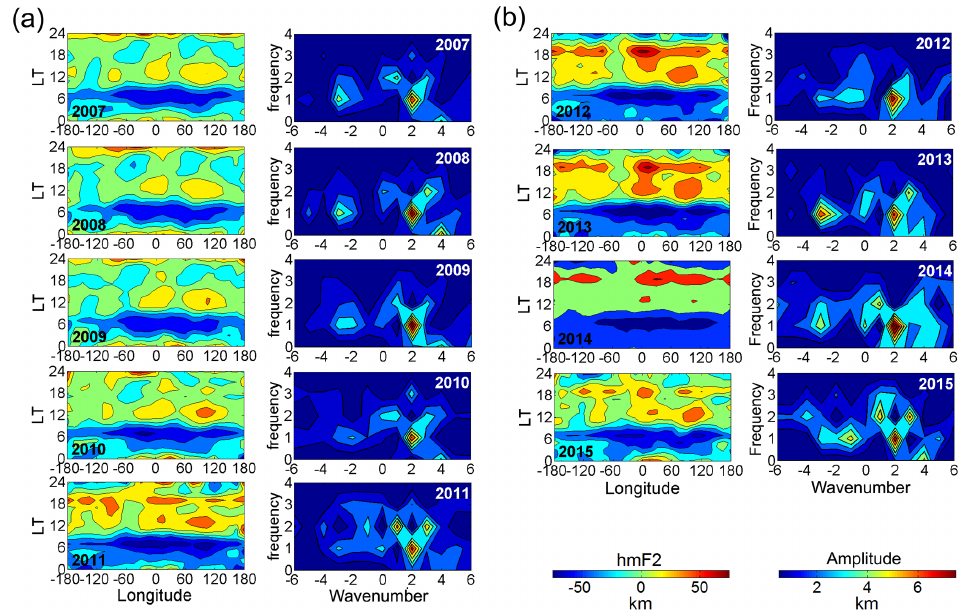
Figure 4. (a) LT × longitude hm F2 contour plots from 2007 to 2015 around September equinoxes. (b) Amplitudes obtained for non-migrating tides indicating their frequency (1/day) and respective zonal wavenumber. The corresponding year for each plot is indicated in the graphs.